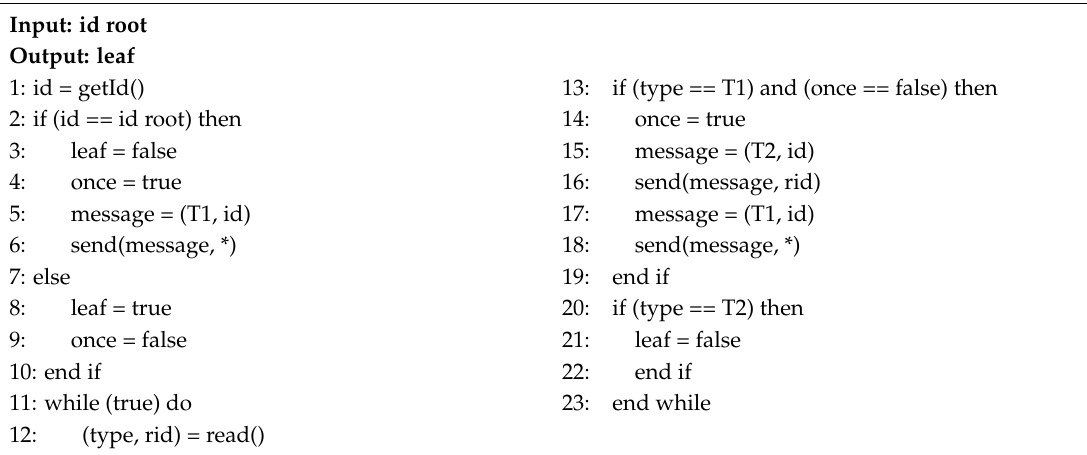
Algorithm 1 Building the tree